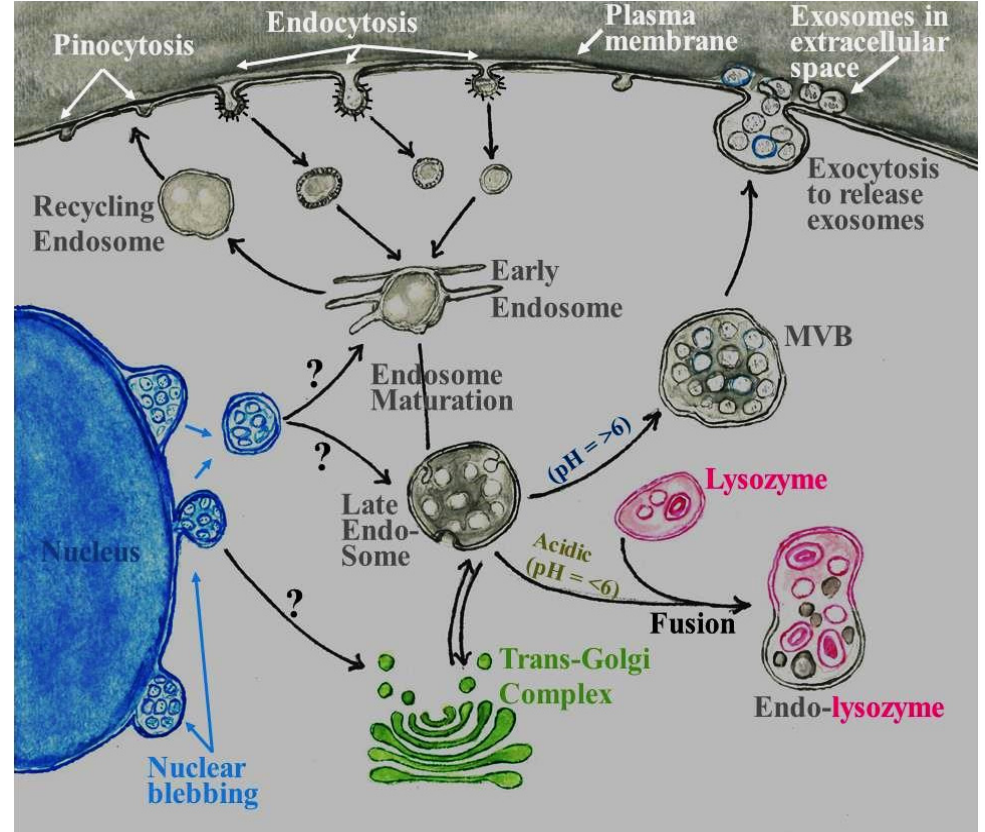
Figure 1. Cellular events related to biogenesis and release of exosomes from the cell. Pinocytosis, clathrin (bristle-coated)-mediated and clathrin-independent endocytosis phosphate) from the trans - Golgi network and phagosomes (not shown here). The lumen of late endosomes becomes acidic due to the progressive concentration of ATP-driven H+ pumps in the vesicle membrane. Acidification is a complex phenomenon not completely understood. If the pH in the lumen is below 6, then late endosomes fuse with lysosomes for degradation and recycling of their content. However, if the pH in the lumen of late endosome is above 6, then they escape fusion with lysosomes and subsequent hydrolysis. During maturation of early endosomes to late endosomes, intraluminal vesicles arise from inward invaginations of the internal membrane. RNAs, proteins, and lipids are incorporated into developing intraluminal vesicles through ESCRT-dependent and ESCRT-independent mecha- nisms. Late endosomes packed with intraluminal vesicles have a multivesicular appearance and are identified as multivesicular bodies. They migrate towards and fuse with the plasma membrane to release their intraluminal vesicles, i.e., exosomes into the extracellular space. Nuclear blebbing ap- pears to generate structures similar to multivesicular bodies (here referred to as MVB type II) that eventually detach from the nuclear membrane and become cytosolic. The MVB type II packed with RNA and/or genomic DNA may receive RNA-binding proteins from the nucleus and/or the trans - Golgi network and fuse with early/late endosomes to export their intraluminal vesicles into the ex- tracellular space. Figure 1 was drawn by authors based upon [20,24–28].